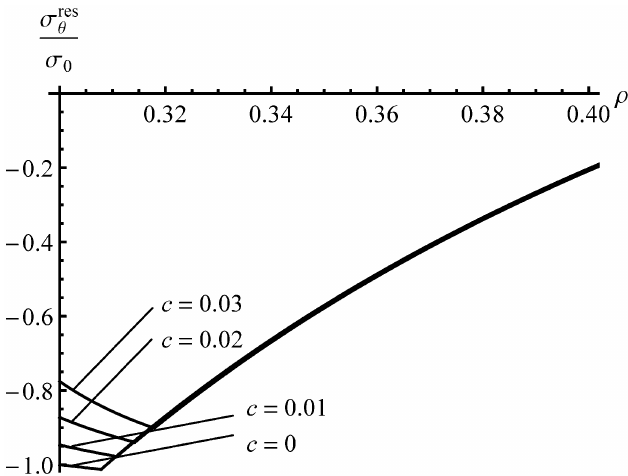
10 of 13 Figure 4. Distribution of the residual circumferential stress in an a = 0.4 cylinder. To reveal an effect of a on the distribution of the residual stresses, the solution for an